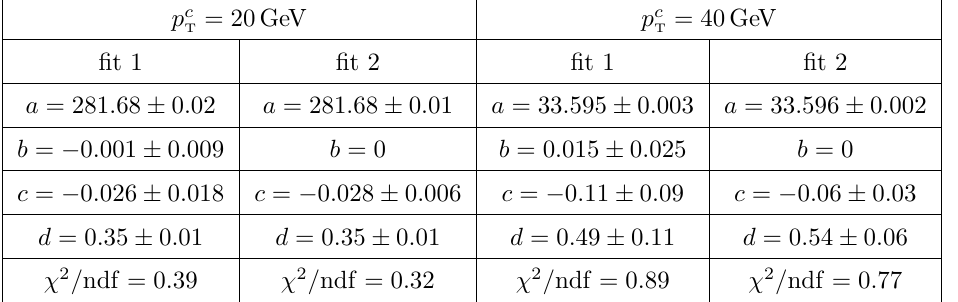
Table 2 . Results of the fit of the T ( λ ) function defined in eq. (2.16) illustrated in figure 10. The fit function is given in eq. (4.2). The first fit corresponds to the blue lines, while in the second fit the linear coefficient has been set to 0 and corresponds to the red lines. The last line corresponds to the associated reduced χ 2